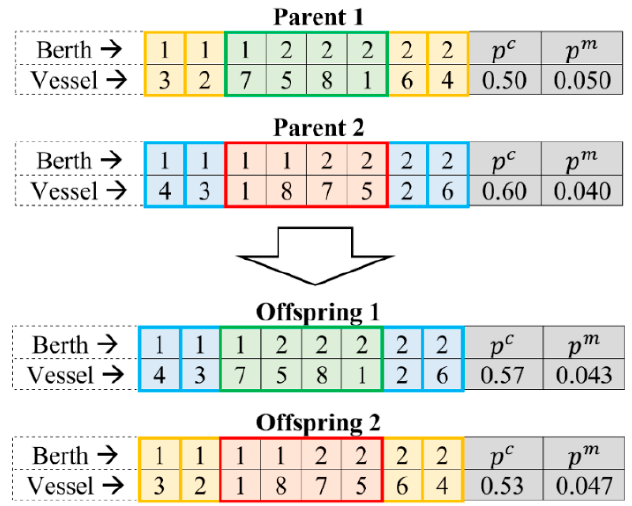
Figure 5. An example of the SAEA crossover operation.